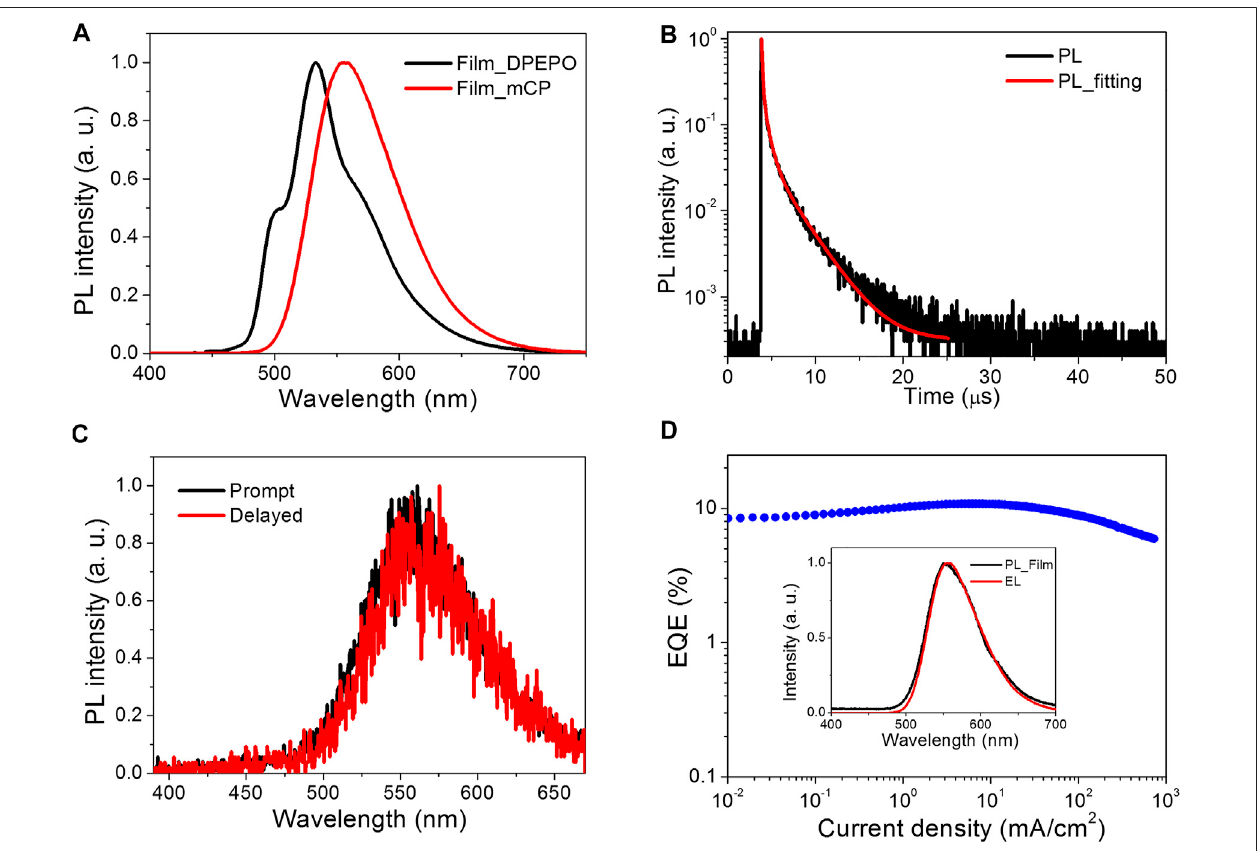
FIGURE2|(A) PLspectraof8 wt%HAP-3DFinDPEPOandmCP. (B) TransientPLdecayof8 wt%HAP-3DF:mCP. (C) PromptanddelayedPLspectraof8 wt% HAP-3DF:mCP at 300 K. (D) EQE as a function of current density. Inset: PL spectrum in 8 wt% HAP-3DF:mCP and EL spectrum recorded at a current density of 10 mA cm − 2